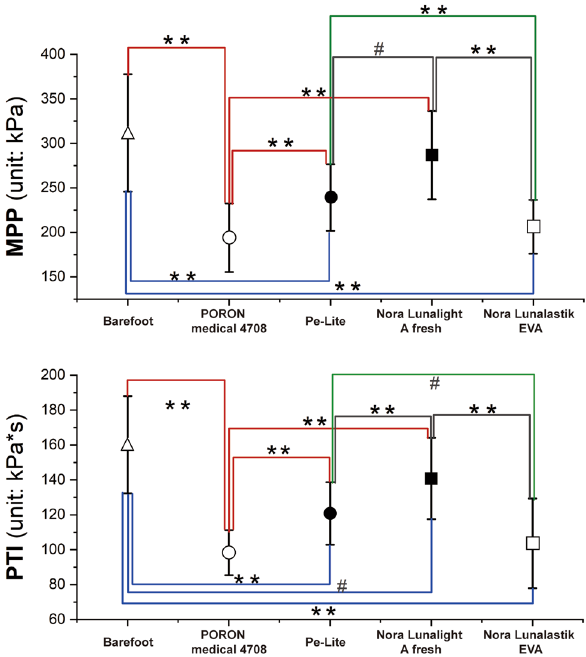
Figure 3. MPP and PTI values of dominant foot. Notes: # P < 0.05 and ** P <